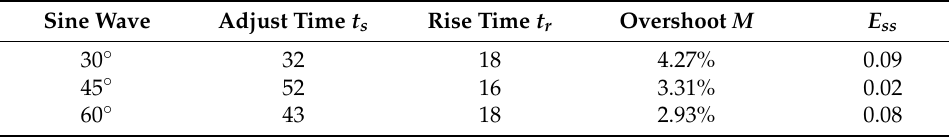
Figure 21. Rudder curves in two different learning samples. Table 2. Performance in learning sample of Sine